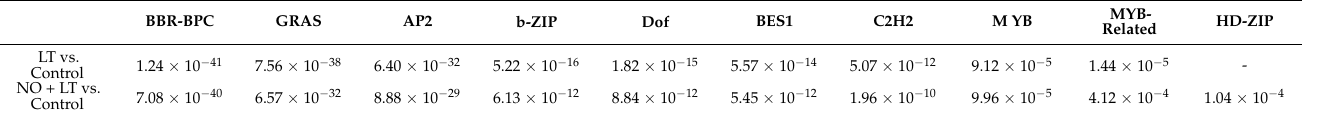
Table 1. The upstream transcription factors (TFs) enrichment results.